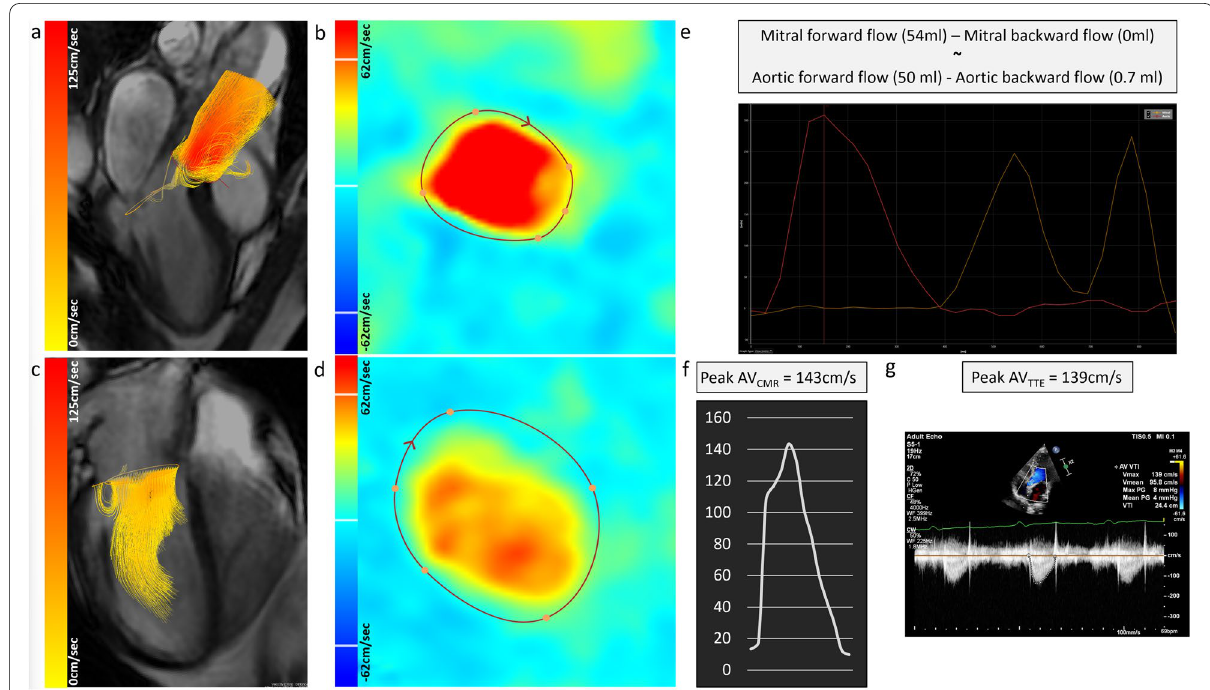
Fig. 2 A case example from the study. Flow streamlines of aortic forward flow ( a ). Quantification of aortic forward flow using the reformatted phase‑contrast plane ( b ). Mitral inflow quantification using retrospective valve tracking procedures ( c , d ). Demonstration of total flow and conservation of mass principle, i.e. , mitral forward flow (MFF) minus mitral backward flow (MBF) is equal to aortic forward flow (AFF) minus aortic backward flow ABF ( e ). Peak velocity through the aortic valve using three‑dimensional streamlines to automatically trace the transvalvular peak ( f ). Echocardiography continuous Doppler method for peak velocity assessment through the aortic valve ( g )